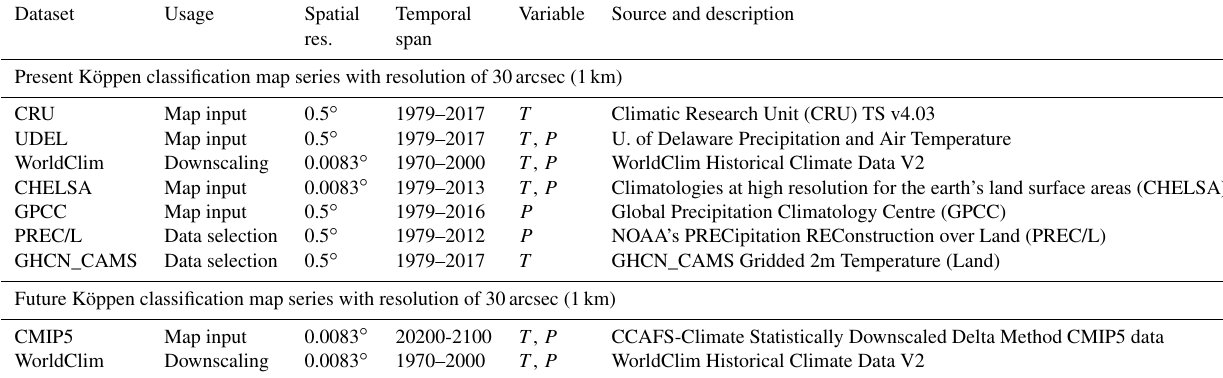
Table 1. Climatology datasets to generate present global maps of the Köppen climate classification with varied spatial resolutions.